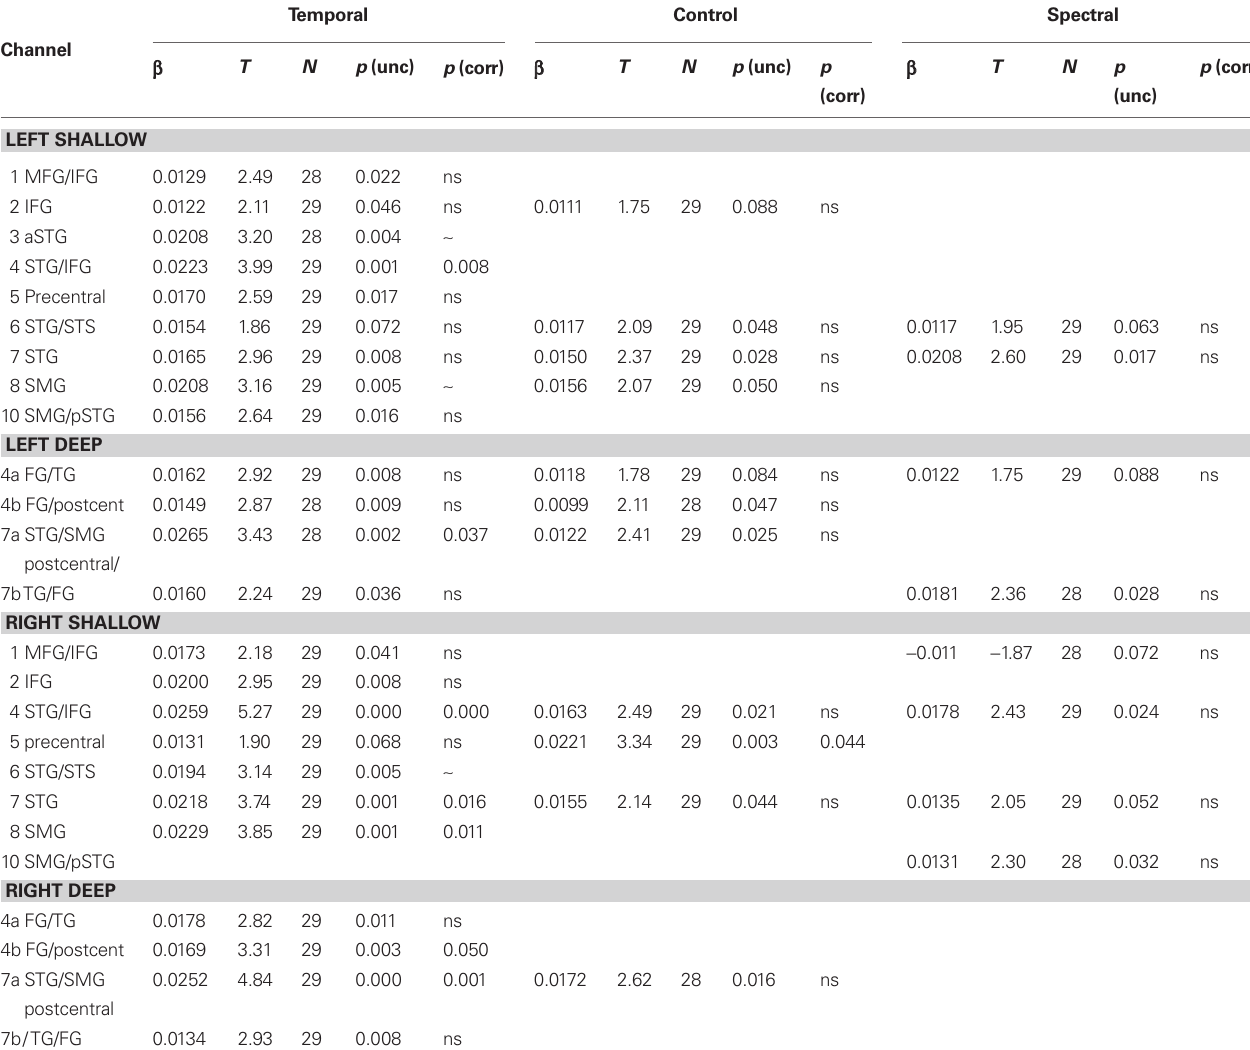
Table 1 | Levels of activations (oxy-Hb changes) for temporal, control, and spectral conditions. Temporal Channel